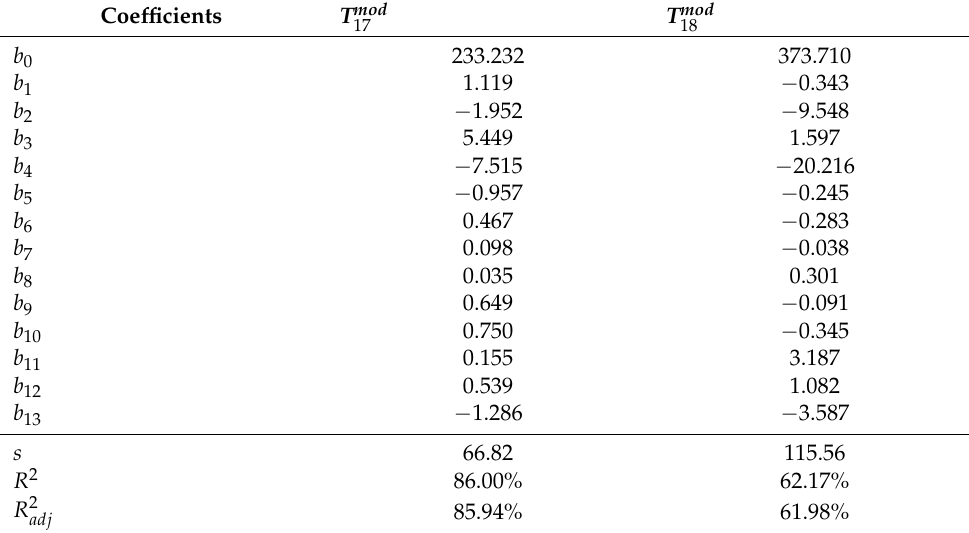
Table 5. Coefficients of regression models for coal temperatures and values of multiple coefficient of determination and standard error of the estimate (Source: own